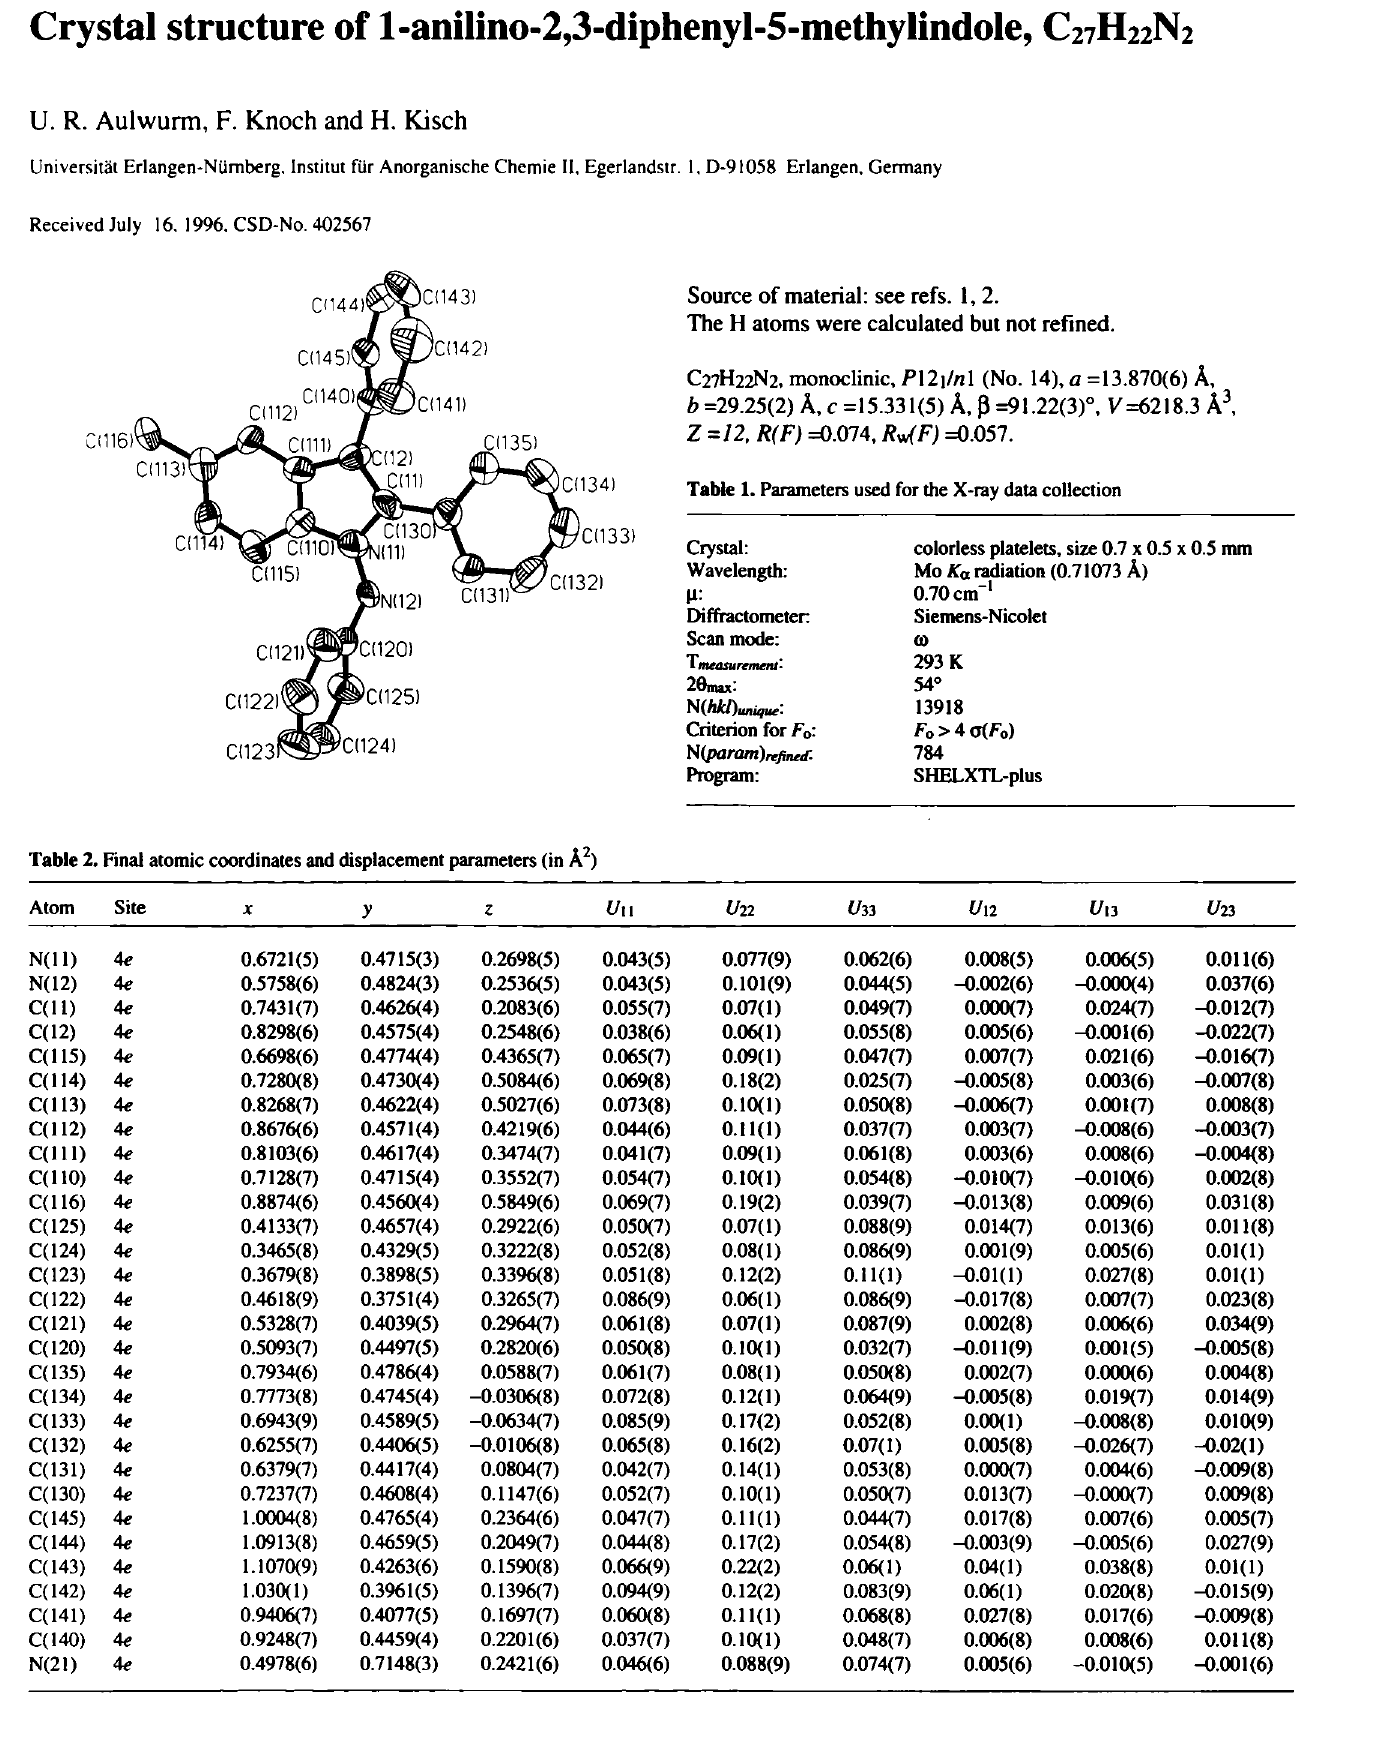
Table 1. Parameters used for the X-ray data collection Crystal: